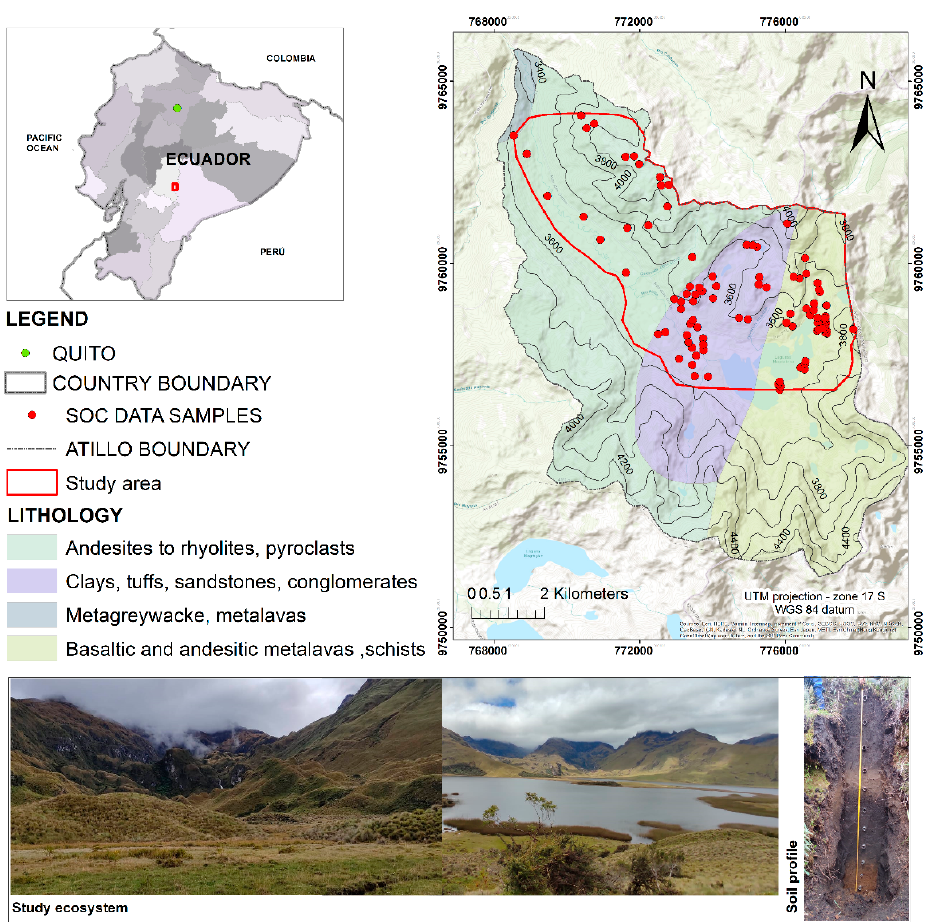
Figure 1. Study area corresponding to Atillo micro-watershed of Sangay National Park and soil sample points.